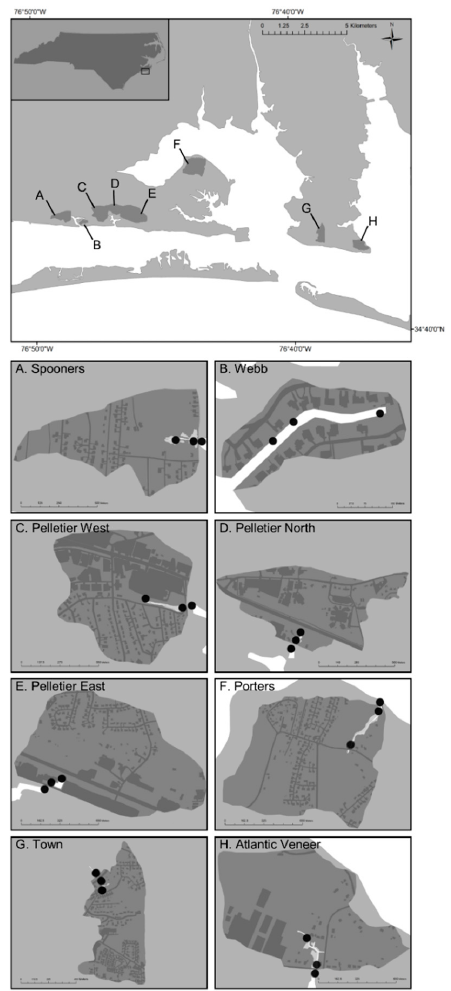
Figure 1. Overview maps (top of figure) and creek-specific maps (bottom of figure) for eight first- order tidal creeks in coastal North Carolina (USA) studied for juvenile blue crab Callinectes sapidus occupancy dynamics. The medium and dark gray shading in each creek-specific map represent watershed area and impervious area within the watershed, respectively. The light gray shading and white in each creek-specific map denote high tide wetted area and permanently wetted area, respectively. The black dots in each panel represent fixed trapping sites (three per